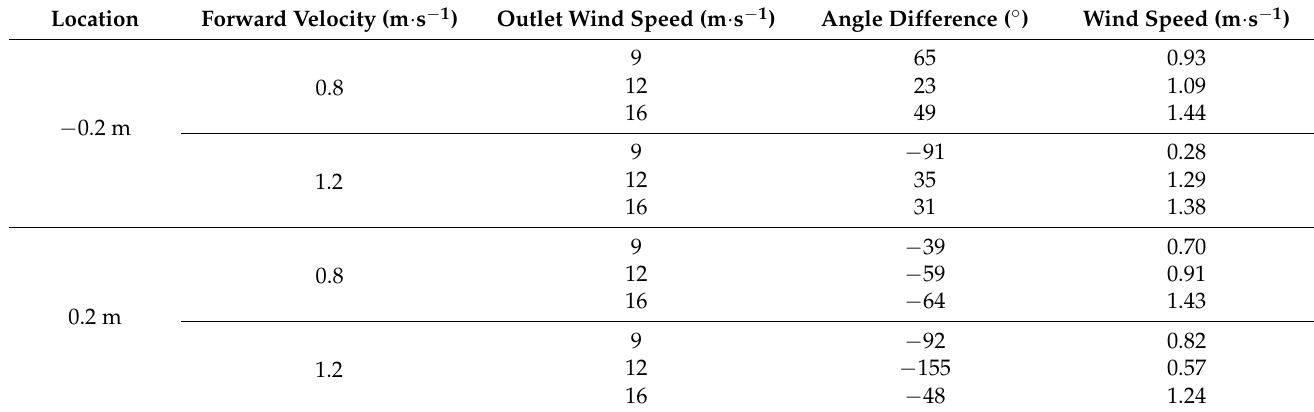
Table 4. Dynamic wind field of the UV plane at − 0.2 and 0.2